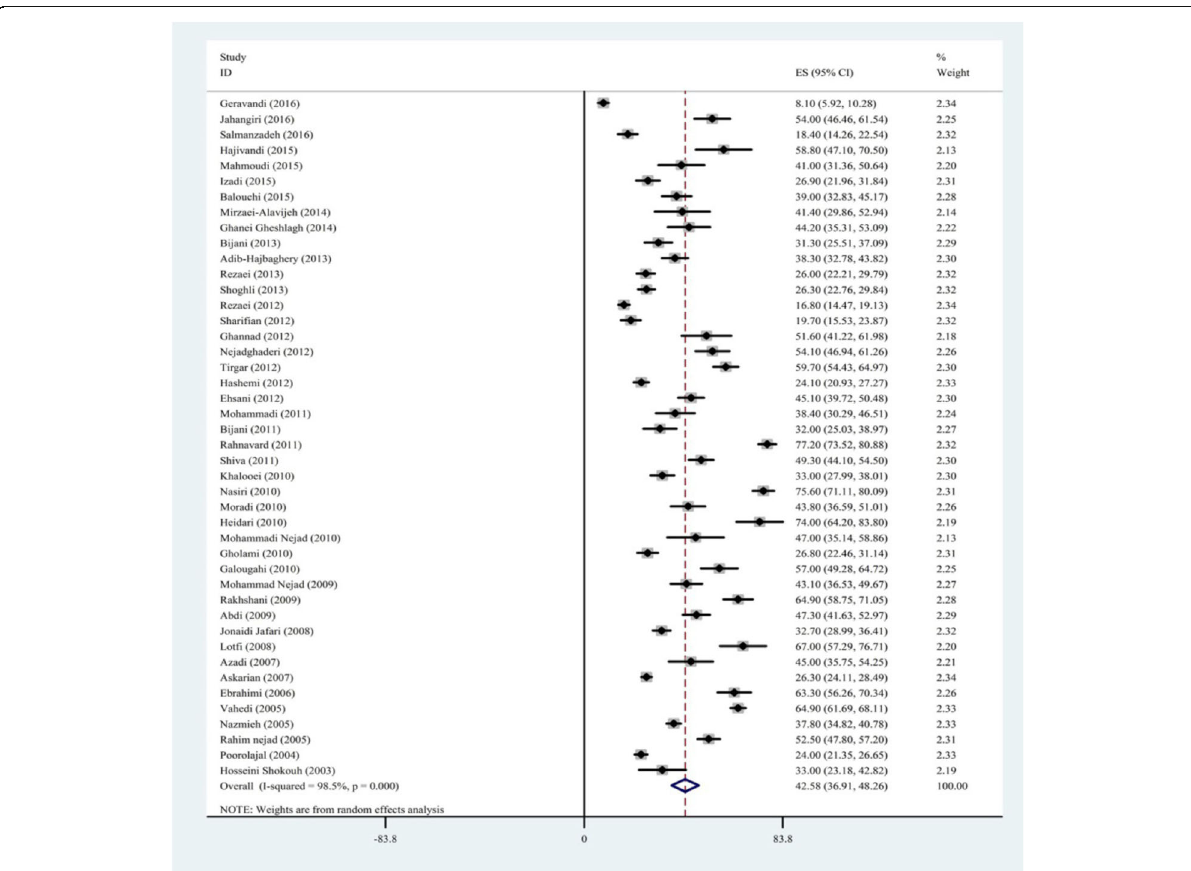
estimate the overall prevalence as it is mentioned at the bottom of the figure. This figure displays the estimation of each study with square and the 95% confidence interval for the relevant estimation with a horizontal line. Square size shows the weight of each study in meta-analysis. The diamond shown at the bottom of the figure indicates the weight of all squares. Horizontal diameter of the diamond shows the possible range of prevalence outcome. Two vertical lines are shown in the figure. The dotted vertical line which is in line with diamond vertical axis shows the overall meta-analysis outcome (pooled prevalence). Another continuous vertical line shows the null hypothesis or no effect which is zero